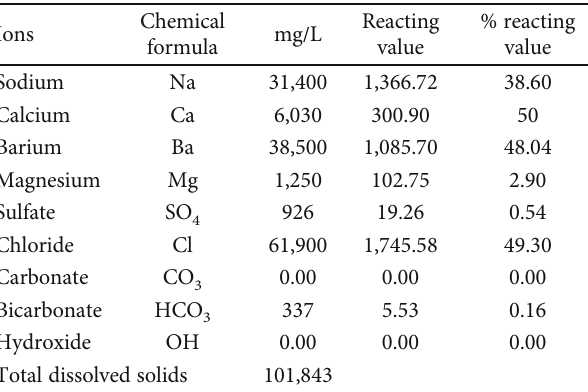
Table 3: Chemical analysis results for the fi eld produced